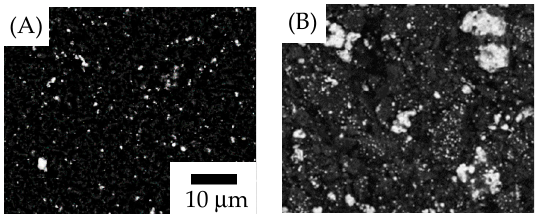
Figure 3. BSE images of Ag over Ag(5.6)-Na(1)/CaCO 3 ( A ) and Ag(56)-Na(1)/CaCO 3 ( B ). The scale of these figures is the same.